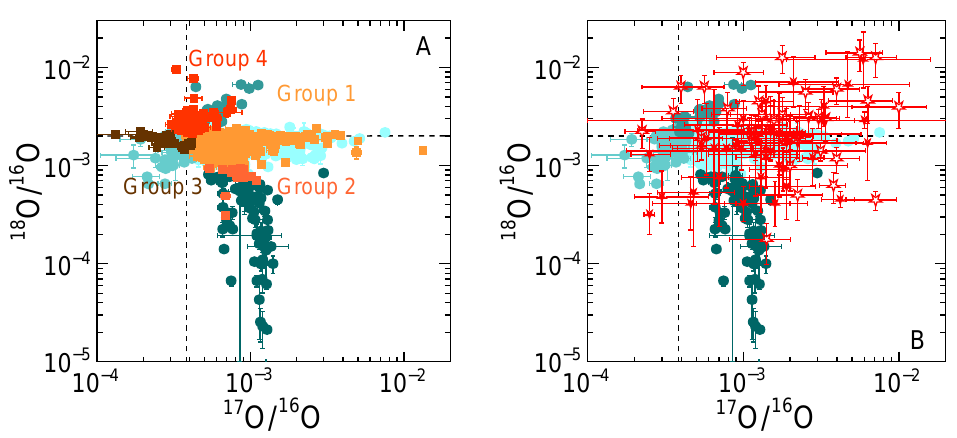
Figure 2. ( A ) Oxygen isotopic ratios in presolar silicate grains, from the WUSTL database [14] (orange squared symbols). Labels and colors identify grains belonging to different groups as it is for oxide grains (cyan dots) in Figure 1. Silicate grains overlap to the oxide one in the oxygen three-isotope plot. ( B ) Comparison between the oxygen isotopic ratios of oxide grains (the same of Figure 1) and the abundances measured in AGB stars by (Hinkle et al. [23] open red stars) and (Lebzelter et al. [24] full red